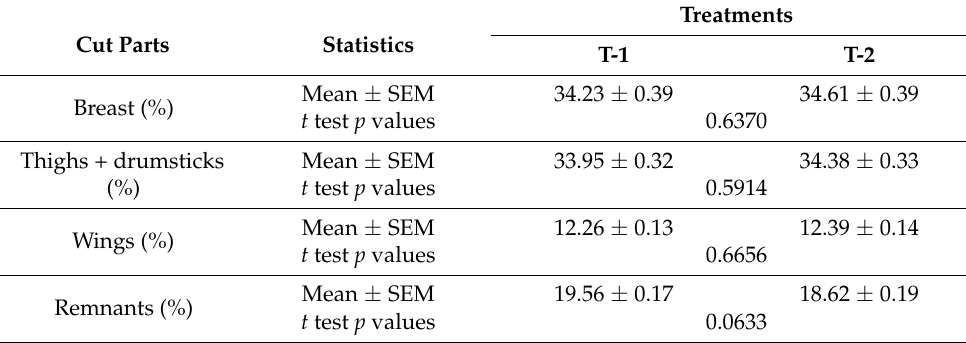
Table 8. Proportions of cut parts in